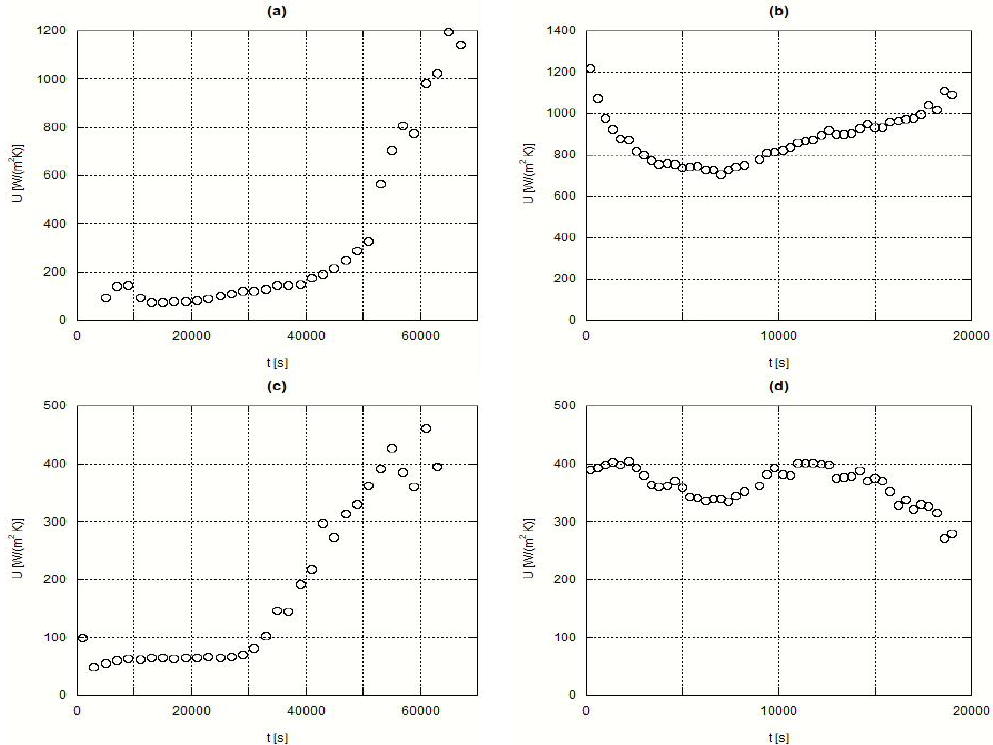
Figure 8. Evolution of the overall conductance U for H105. Left column fusion process; Right column, solidification process. Plots ( a , b )—t1 test conditions; Plots ( c , d )—t2 test conditions.